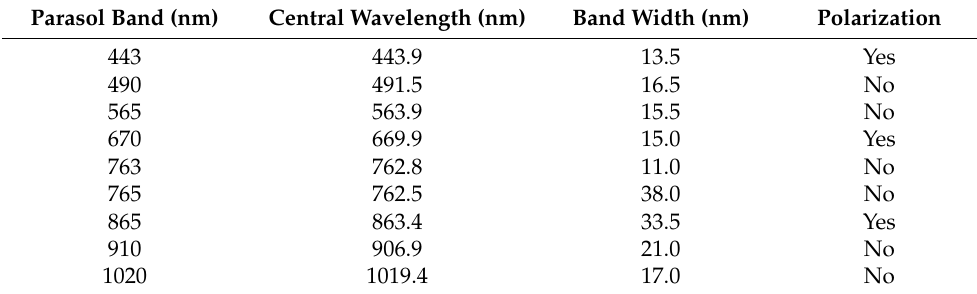
Table 2. Spectral band characteristics for POLDER/PARASOL. Central Wavelength Parasol Band (nm) (nm)